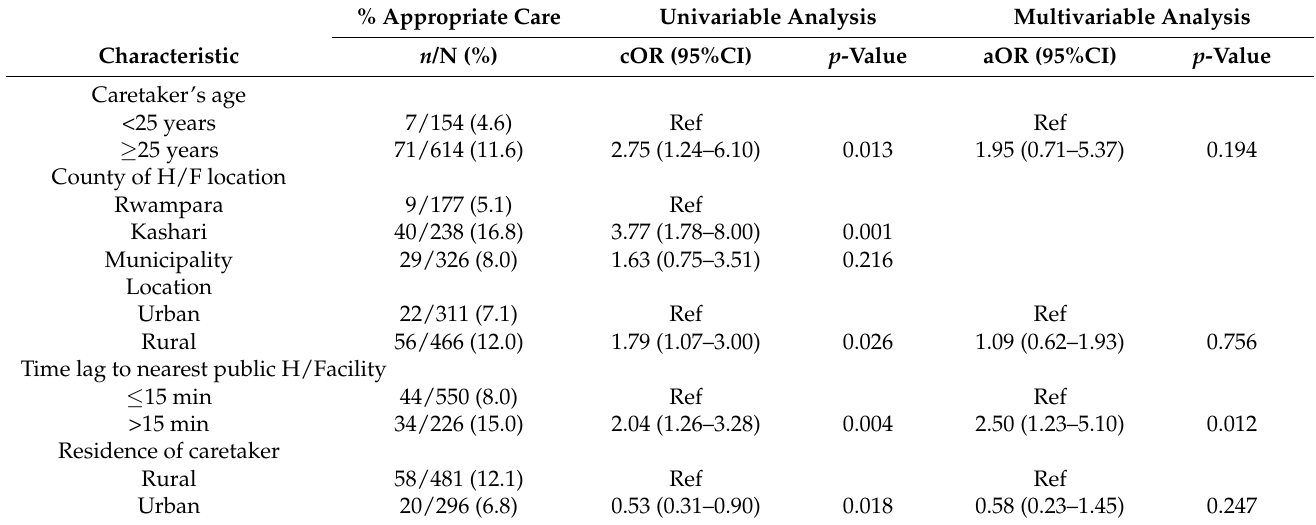
Table 5. Factors associated with appropriateness of